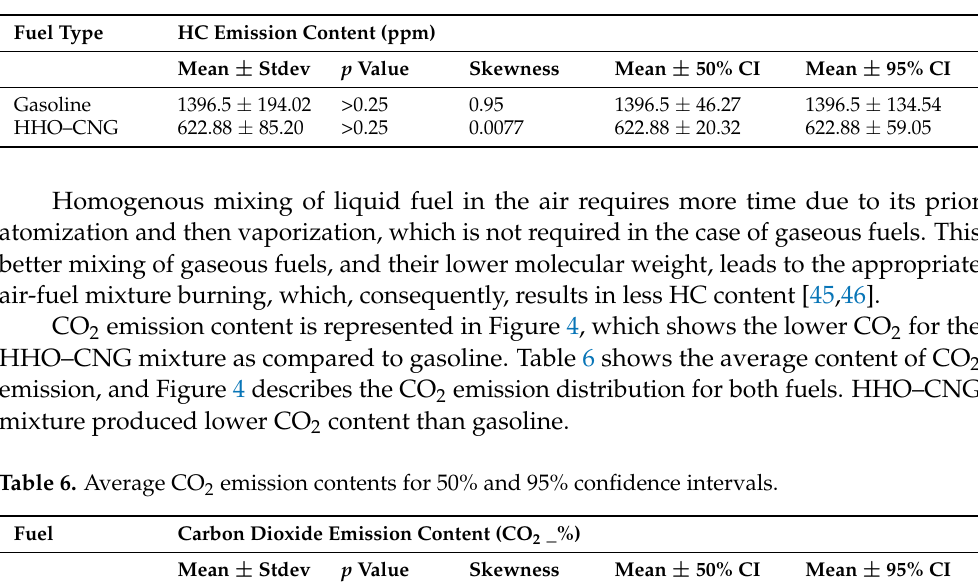
Figure 6. ( a ) NOx Weibull distributions for various CIs using gasoline and ( b ) NOx Weibull distribu- tions for various CIs using HHO–CNG. Table 5. Average HC emission contents for 50% and 95% confidence intervals.